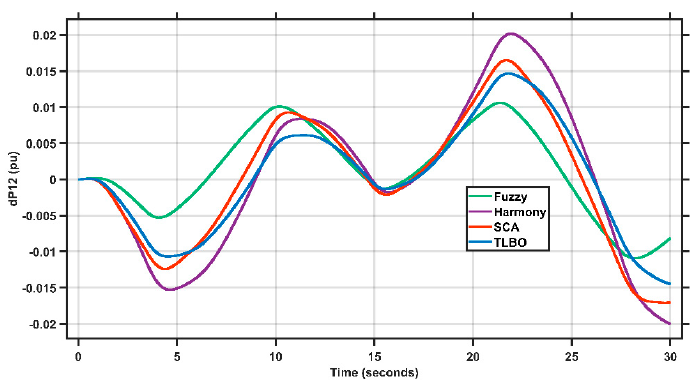
Figure 23. Change in tie power under wave disturbance.